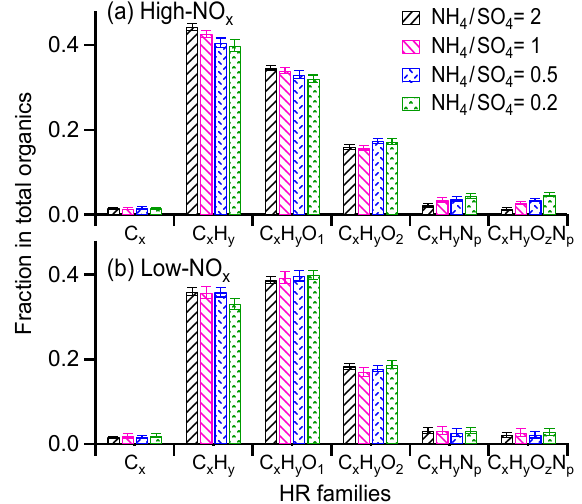
Figure 5. (a) The increase of SOA mass with time for experiments injecting ammonium sulfate and acidic seed particles after α -pinene photooxidation for 2 and 4h under high- and low-NO x conditions, respectively (Exp. 9–12 in Table 1). Time = 0h represents the be- ginning of reactive uptake of oxidation products after seed particles were added. The SOA mass was normalized by the reacted α -pinene concentration before adding seed particles. (b) The ratio of SOA mass for acidic particles to that of ammonium sulfate particles.